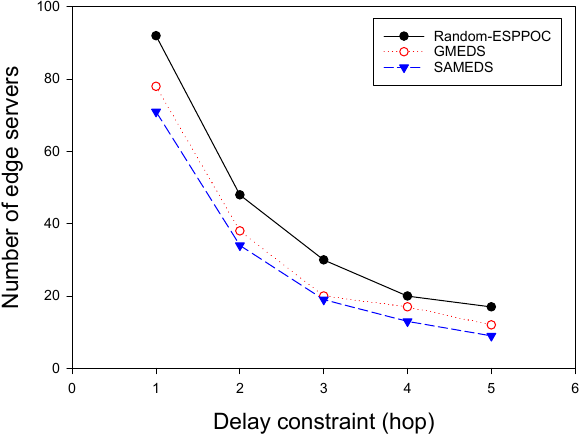
Figure 5. The impact of delay constraint with on-demand capacities.